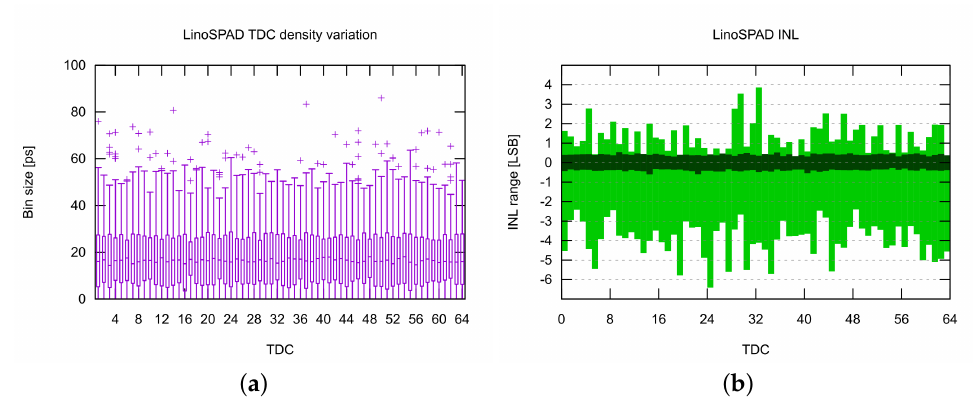
Figure 14. ( a ) TDC-to-TDC density statistics for all TDCs in a given FPGA. Generally, the mean bin size is well below 20 ps, but almost each TDC has some outliers with delays up to 80 ps. ( b ) INL correction efficiency across the 64 TDCs in a camera, showing its effectiveness regardless of the input distributions.